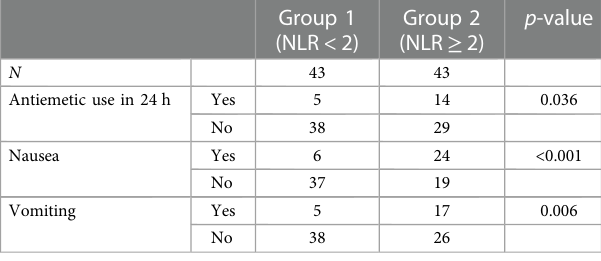
TABLE 2 Comparison of postoperative use of antiemetics and incidence of PONV in two groups.